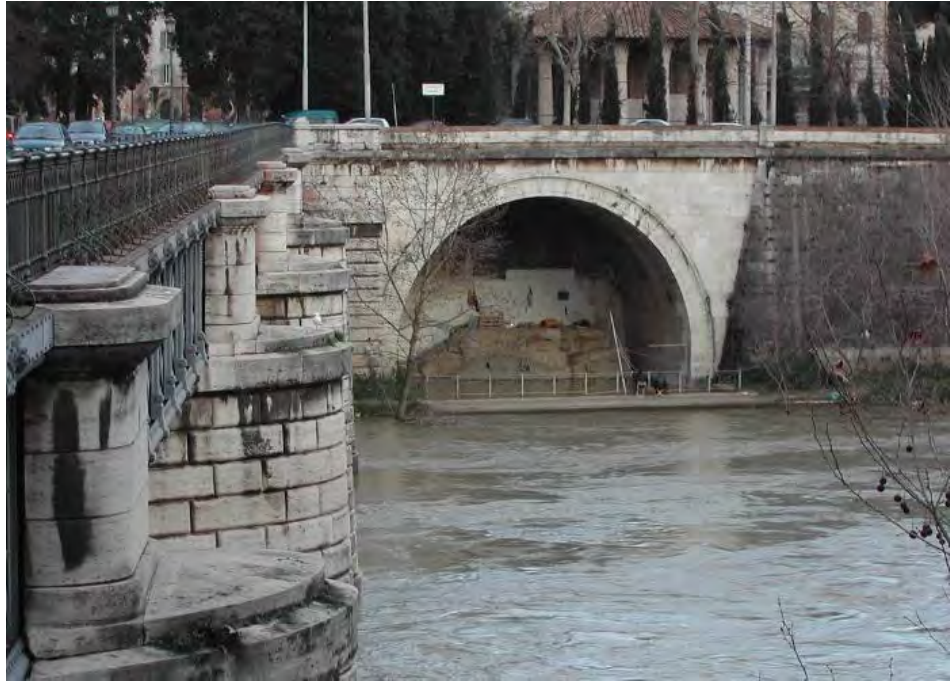
Fig.1: Historical stormwater management. (Atlas Obscura, 2018)